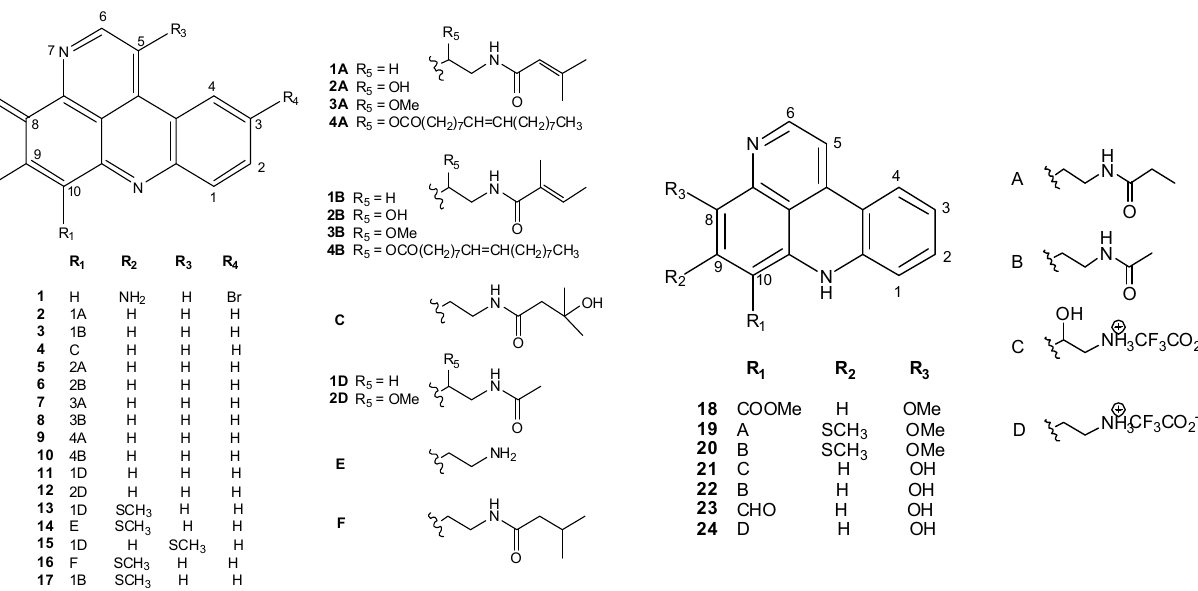
Figure 1. Tetracyclic pyridoacridine alkaloids from